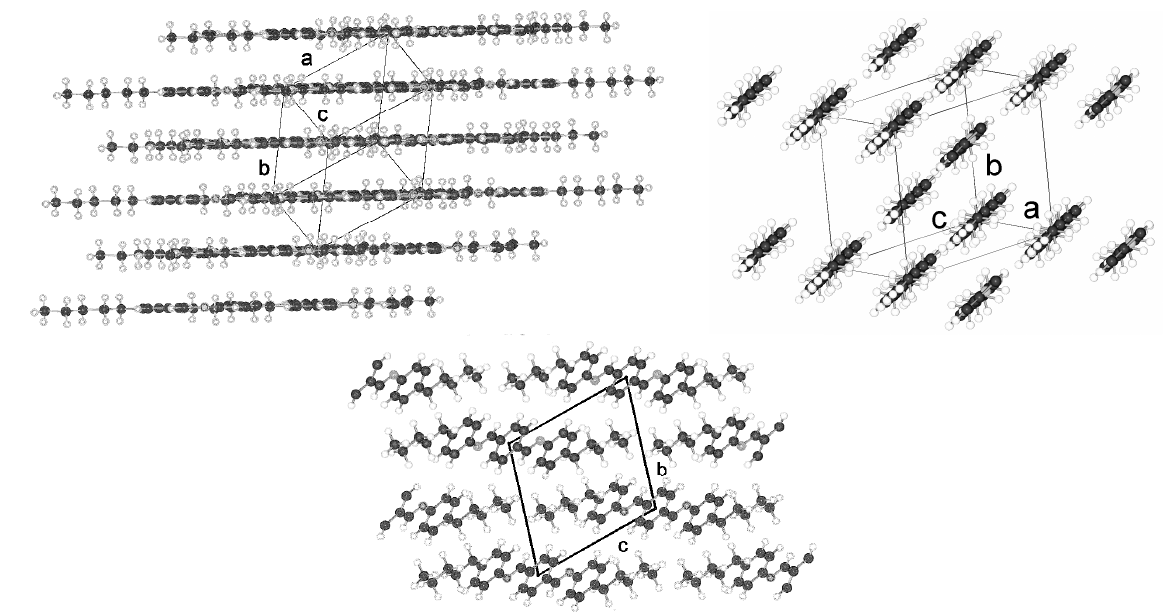
Figure 30. Representation of the packing arrangement of TBAA-5(1) in three projections: One projection shows the molecular planes formed, a second drawing a projection in direction of the molecular axes. Strings can be defined, which can be placed in planes. A third projection in [100] direction represents the stapled and overlapping